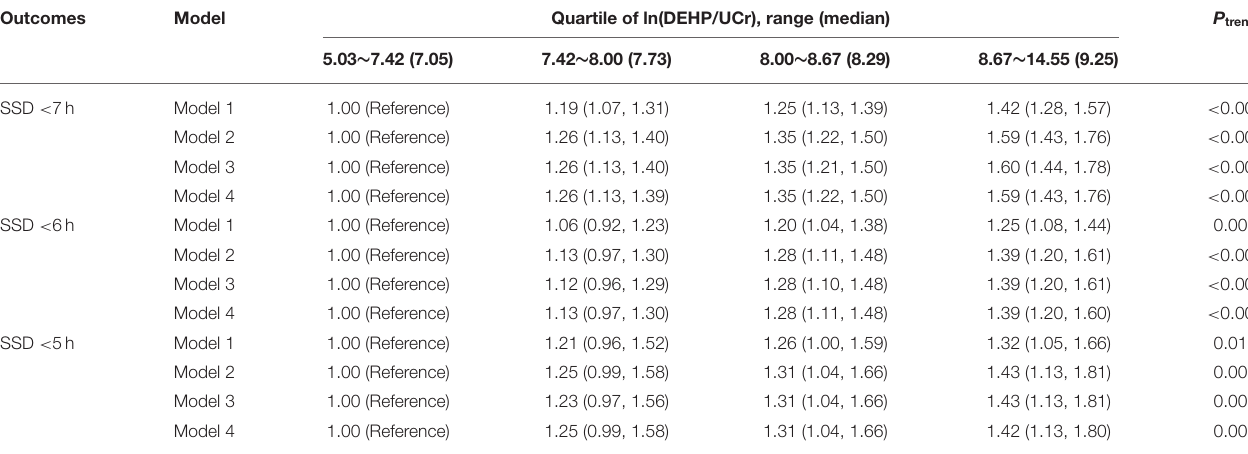
TABLE 3 | Association between DEHP exposure and SSD. Outcomes